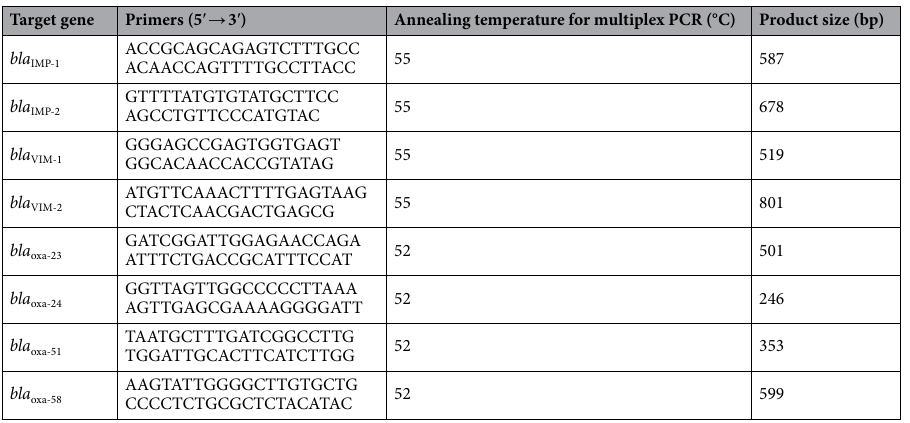
Table 1. Polymerase chain reaction (PCR) primers, conditions, and product size for the detection of carbapenemases among Acinetobacter baumannii